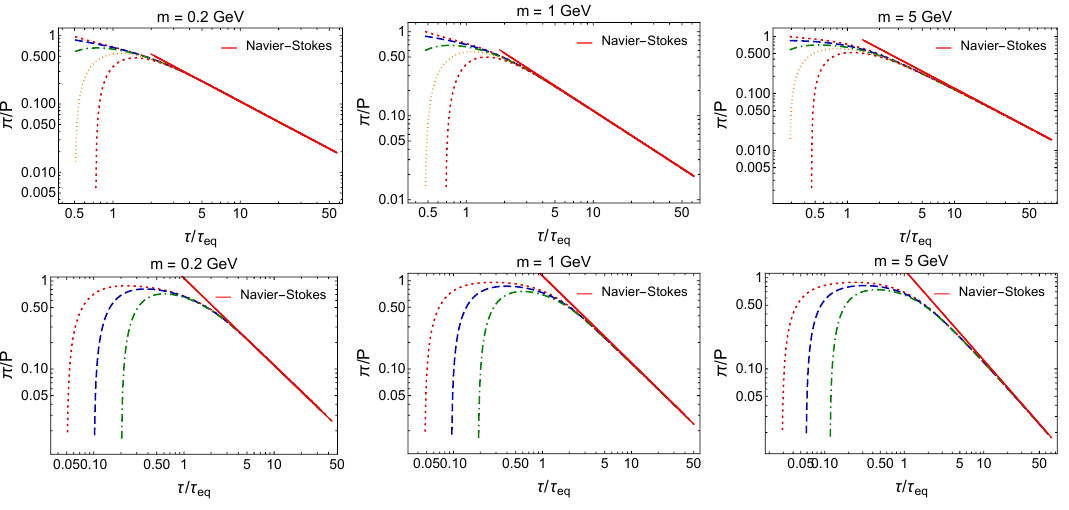
Figure 8 . Scaled shear viscous correction π/P from eq. (2.35) as a function of rescaled time τ/τ eq . The top row shows the result of varying the initial anisotropy and the bottom row shows the result of varying the initialization time. These correspond to the same initializations shown in figures 2–7. Columns from left to right show the cases of m = 0.2, 1, and 5 GeV, respectively. The non-solid curves are specific runs and the solid curve shows the first-order Navier-Stokes prediction given in eq.